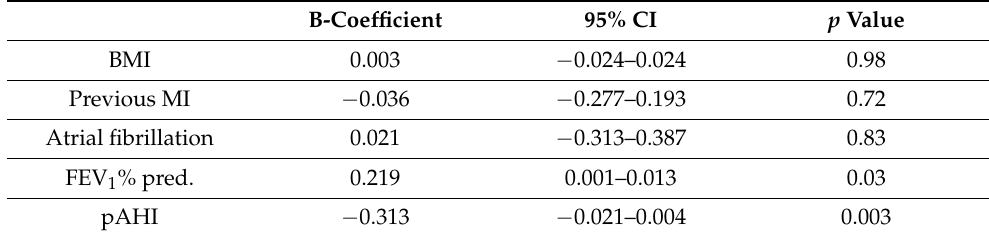
Table 4. Multivariate regression analysis of reactive hyperemia index determinants